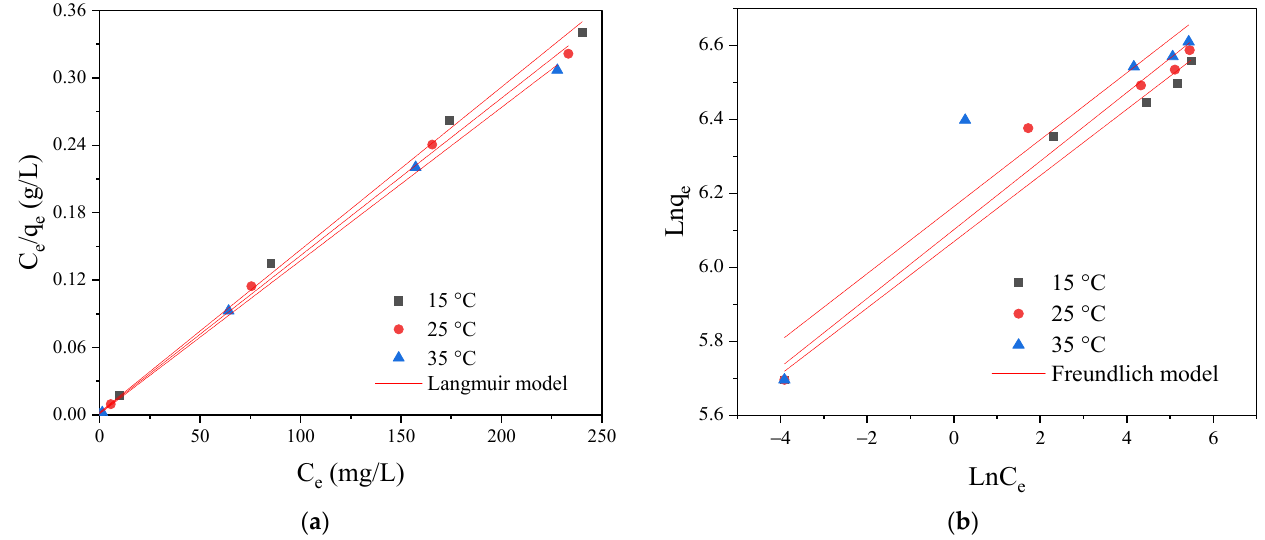
Figure 8. ( a ) Langmuir and ( b ) Freundlich modeling of RY2 adsorption on PEI/APTES-MWCNTs at 15, 25, and 35 °C. Table 3. Langmuir and Freundlich parameters of RY2 adsorption on PEI/APTES-MWCNTs.